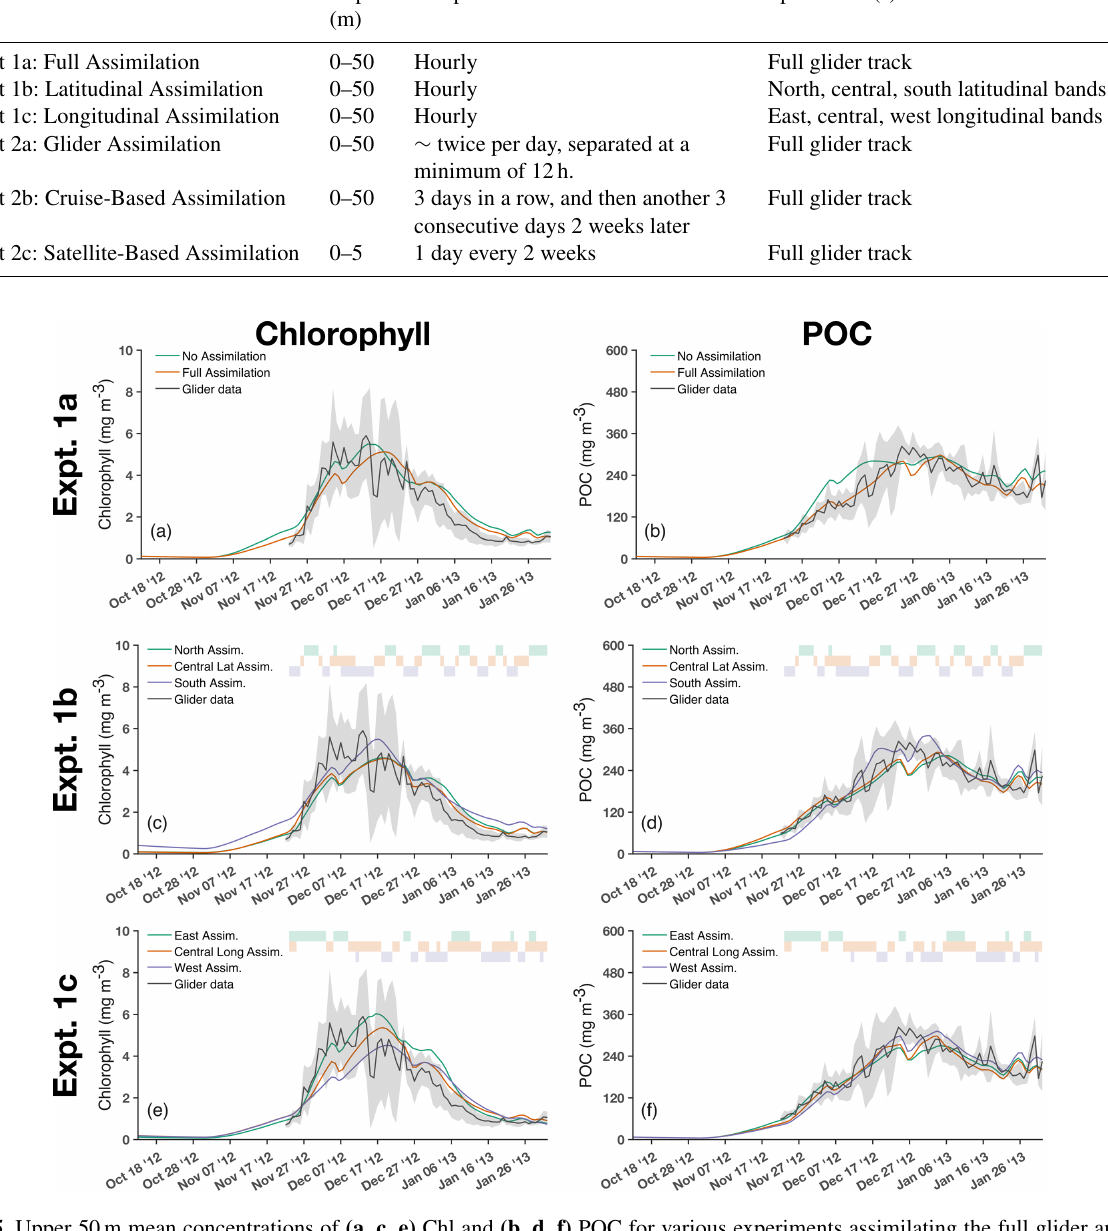
Figure 5. Upper 50m mean concentrations of (a, c, e) Chl and (b, d, f) POC for various experiments assimilating the full glider and from different spatial areas (Table 2): (a, b) Experiment 1a, (c, d) Experiment 1b – latitude bands – and (e, f) Experiment 1c – longitude bands. For reference, glider data (black lines) with shading (gray) representing 1 SD (from the upper 50m) are included in each panel. Colored boxes at the top of each panel indicate times of assimilated